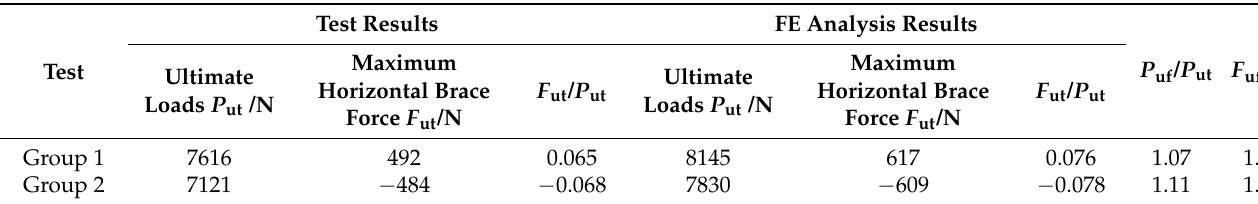
Table 1. Test results and FE analysis results.